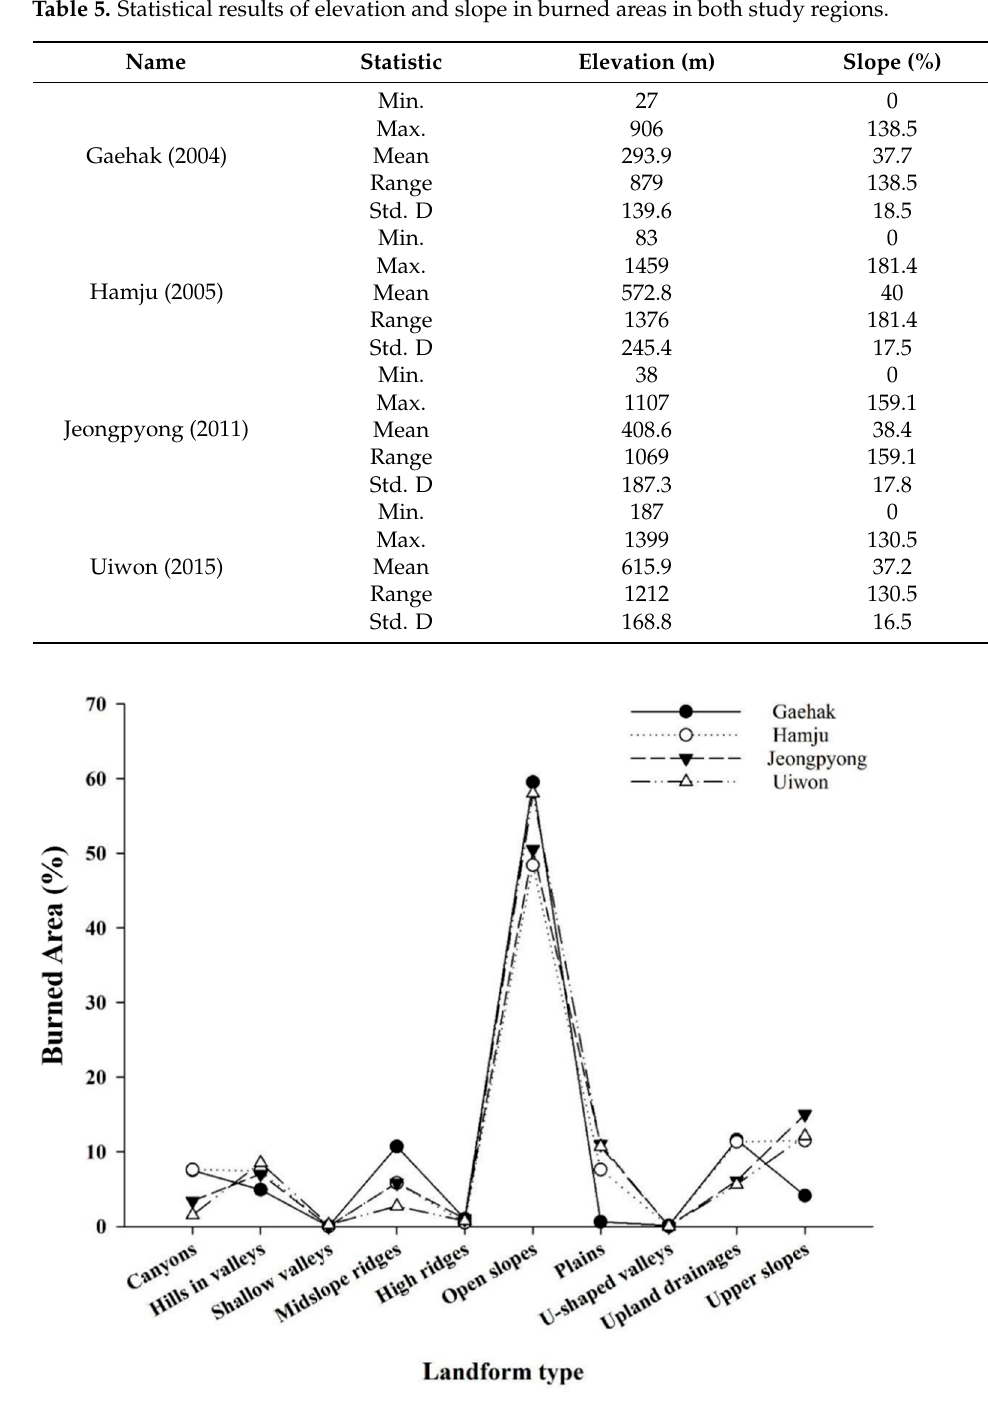
Table 5. Statistical results of elevation and slope in burned areas in both study regions.